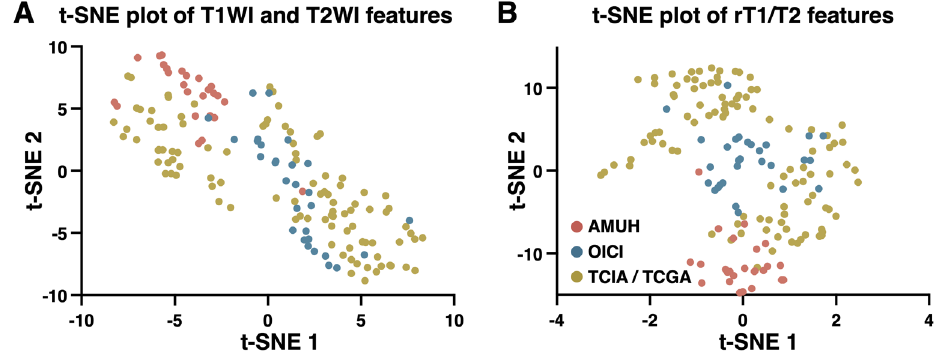
Figure 7. Scatter plots of the imaging texture features of T1WIs and T2WIs ( A ) and rT1/T2 ( B ) analyzed by t-SNE, and color-coded according to